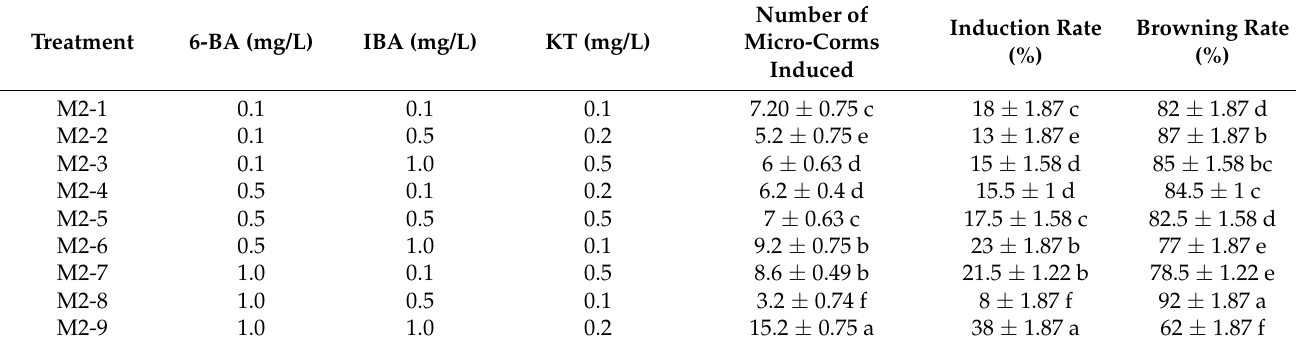
Table 4. Differentiation responses of somatic embryo to various PGR combinations and plant regeneration.